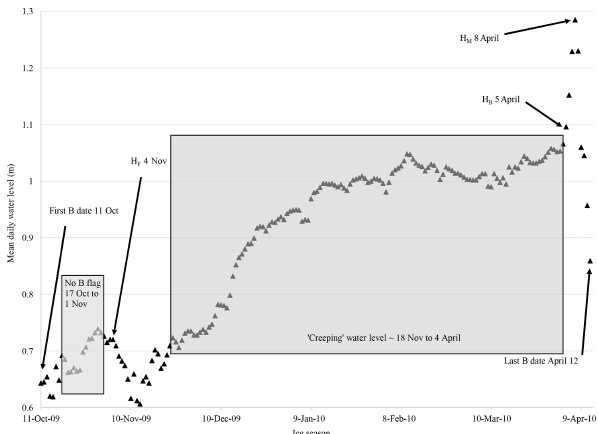
Figure 9. Daily water level from first B date to last B date at Pem- bina River station at Jarvie (07BC002) during the 2009–2010 ice- affected flow season that depict “creeping” water level. There are no B data flags from 17 October to 1 November and daily average water levels creeping upwards throughout the ice cover